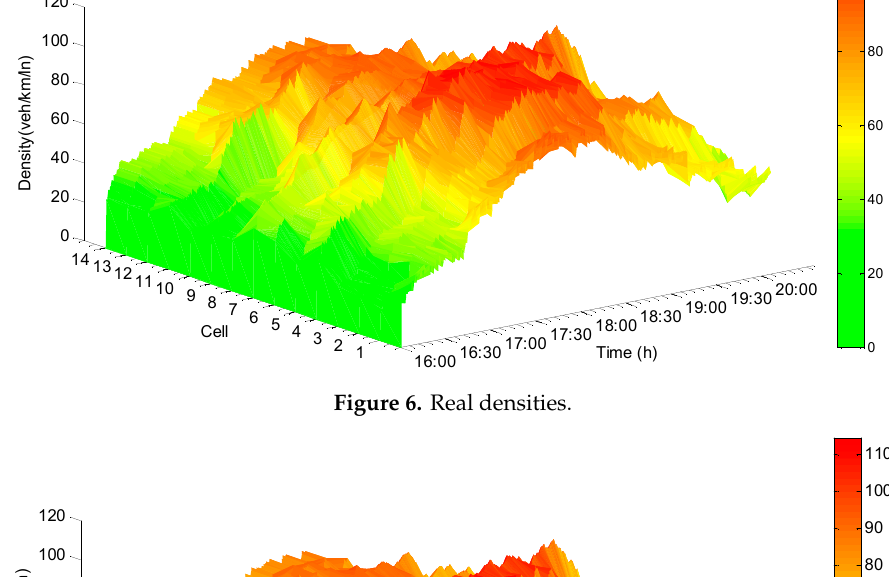
Figure 6. Real densities.